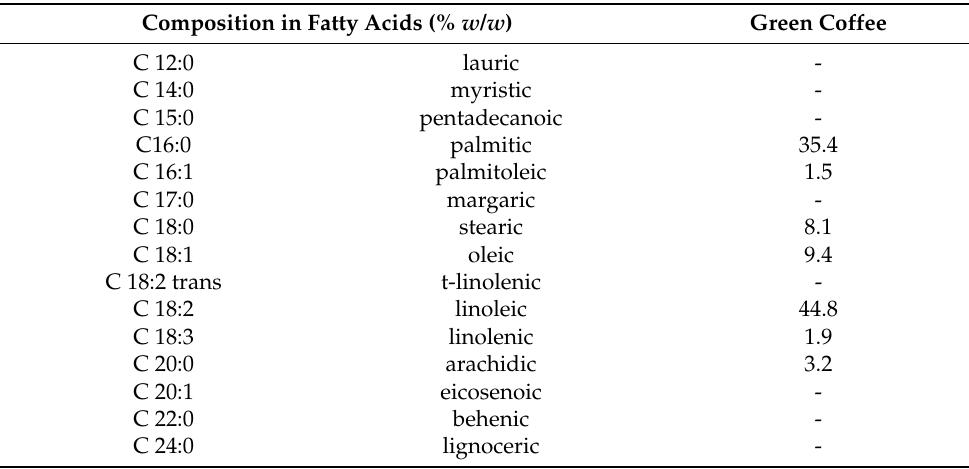
Table 1. Composition in fatty acids of samples of green coffee oil by GC–MS. Composition in Fatty Acids (% w / w )